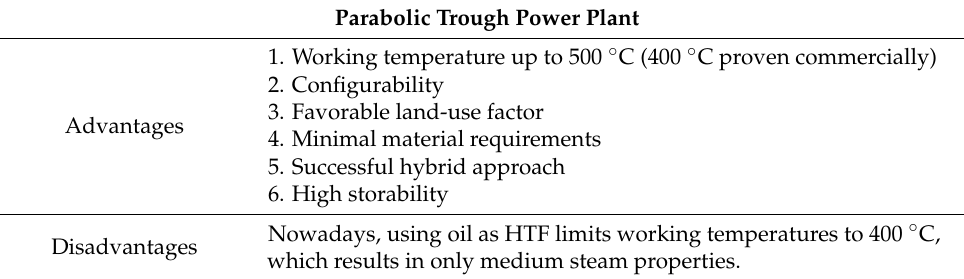
Table 1. Advantages and disadvantages of parabolic trough power plant